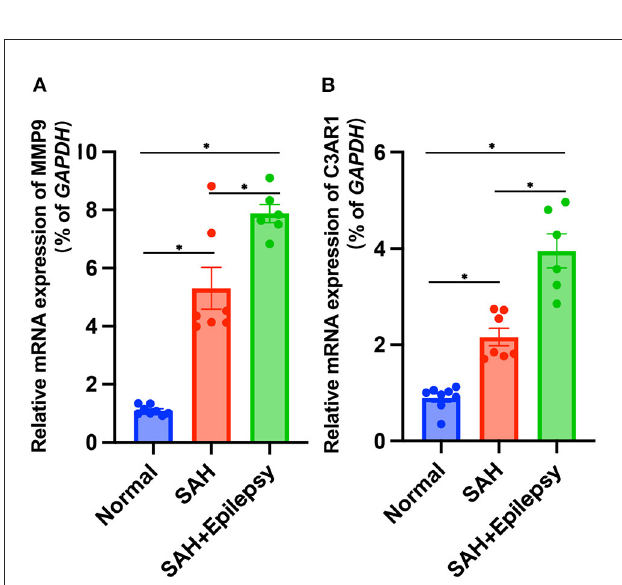
FIGURE11 Validation of RT-qPCR levels via patients. Blue, red, and green represent normal, SAH, and SAH + epilepsy, respectively. SAH, subarachnoid hemorrhage. * P <